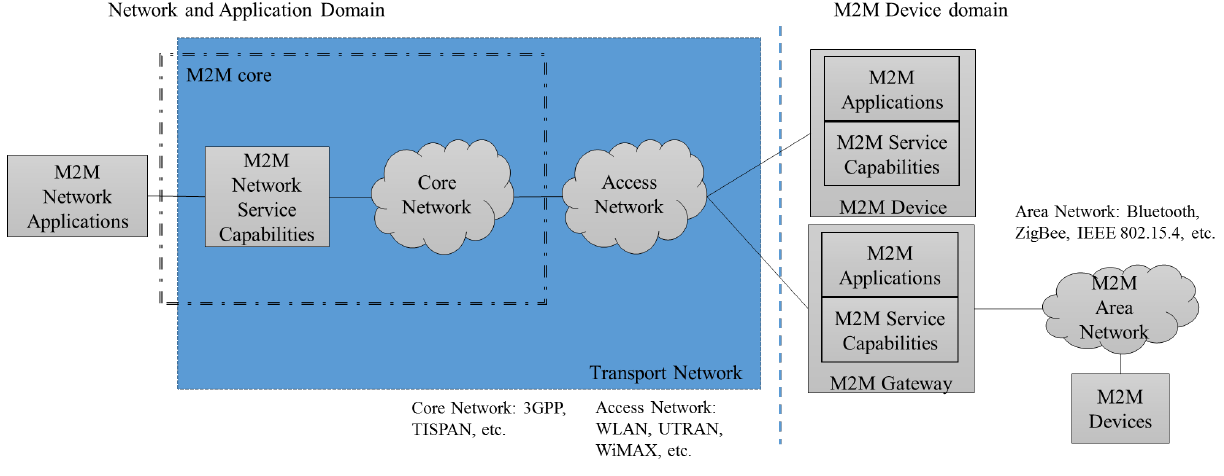
Figure 1. European Telecommunications Standards Institute (ETSI) Machine-to-Machine (M2M) high level system